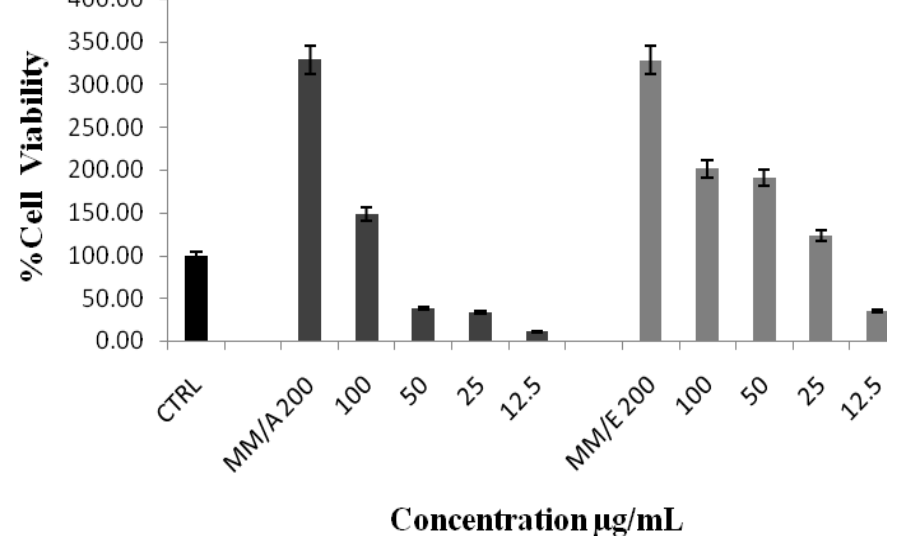
Figure 1. MM’s immunomodulatory effect on human PBMC proliferation, CTRL = distilled water, MM/A = M. malabathricum aqueous extract, MM/E = M. malabathricum ethanol